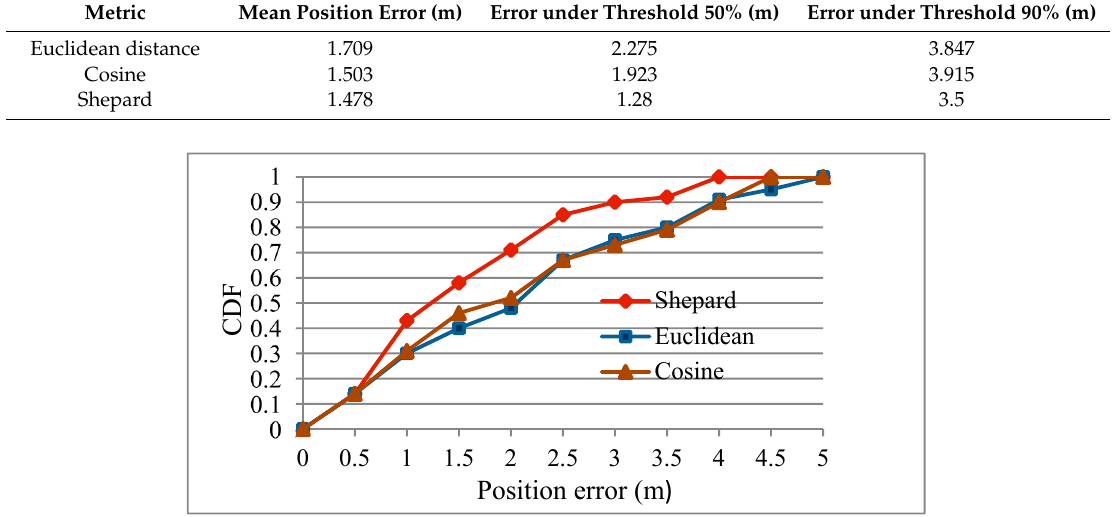
Table 6. Comparison of positioning performance using different localization algorithms.